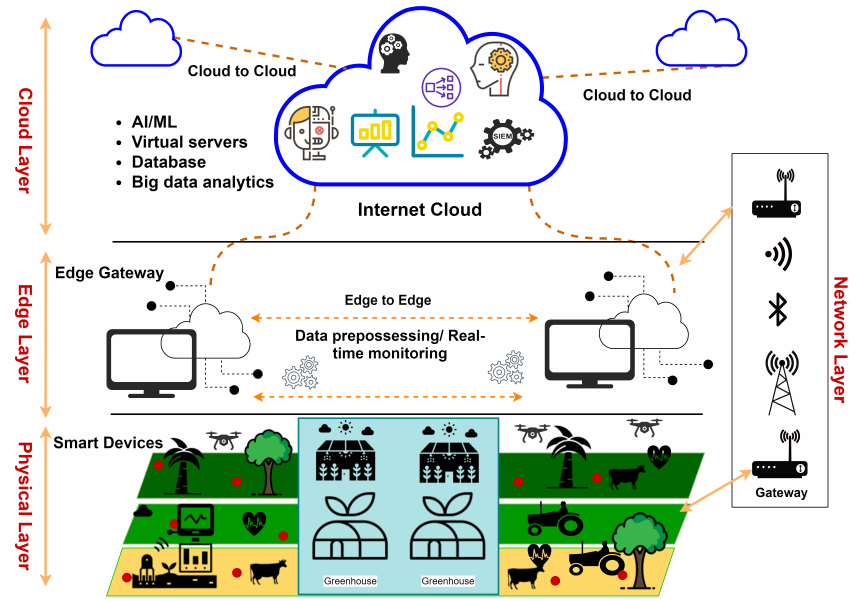
Figure 1. A typical SF